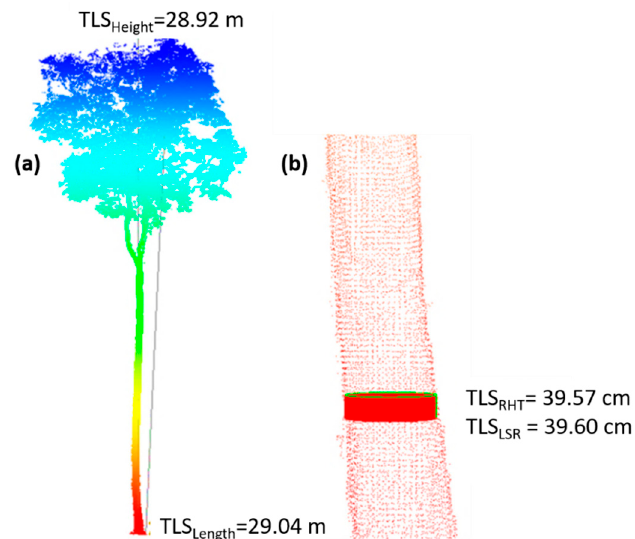
Figure 4. An example of a point cloud and biometric variables obtained with 3D Forest: ( a ) An example for estimating the total tree height (TLS Height = 28.92 m) and the length of the point cloud (TLS Length = 29.04 m) and ( b ) an example for estimating the diameter at breast height (DBH) based on a randomized Hough transformation (TLS RHT = 39.57 cm) and a least squares regression (TLS LSR = 39.60 cm). Note that the estimates of stem height and stem length differ due to an inclination of the tree stem, whereas the estimates of diameter vary due to the different mathematical formulations of the stem ‐ fitting algorithm.